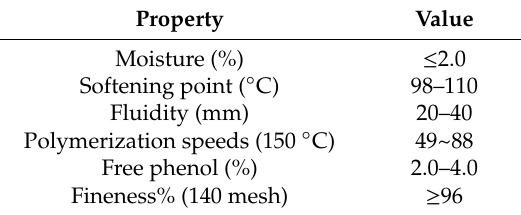
Table 2. Physical properties of phenolic resin